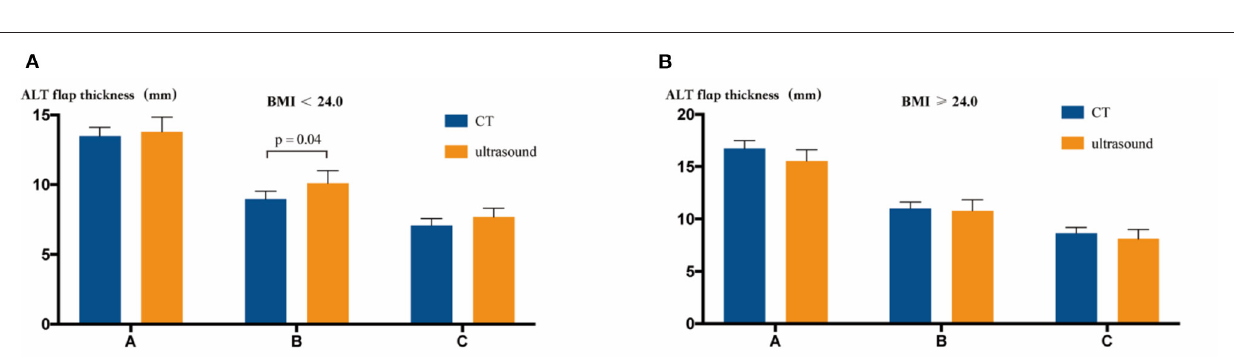
FIGURE 3 | The thickness of the ALT flap was measured at points A, B, and C by CT or ultrasound examination. (A) CT measurement of the ALT flap thickness. Inter-group comparisons showed a statistically significant difference in the thickness at points A, B, and C between the two groups with BMI < 24.0 and BMI ≥ 24.0 ( P < 0.0001, t test). Intra-group comparisons showed statistically significant differences in the thickness at points A, B, and C ( P < 0.0001, ANOVA) within the group of BMI < 24.0 or BMI ≥ 24.0. (B) Ultrasound measurement of the thickness of the ALT flap. Inter-group comparisons showed a statistically significant difference only at point A between the groups with BMI < 24.0 and BMI ≥ 24.0 ( P = 0.03, t test). Intra-group comparison showed statistically significant differences in the thickness at points A, B, and C ( P < 0.0001, ANOVA) within the group of BMI < 24.0 or BMI ≥ 24.0. The bars show the mean values with 95% confidence intervals.